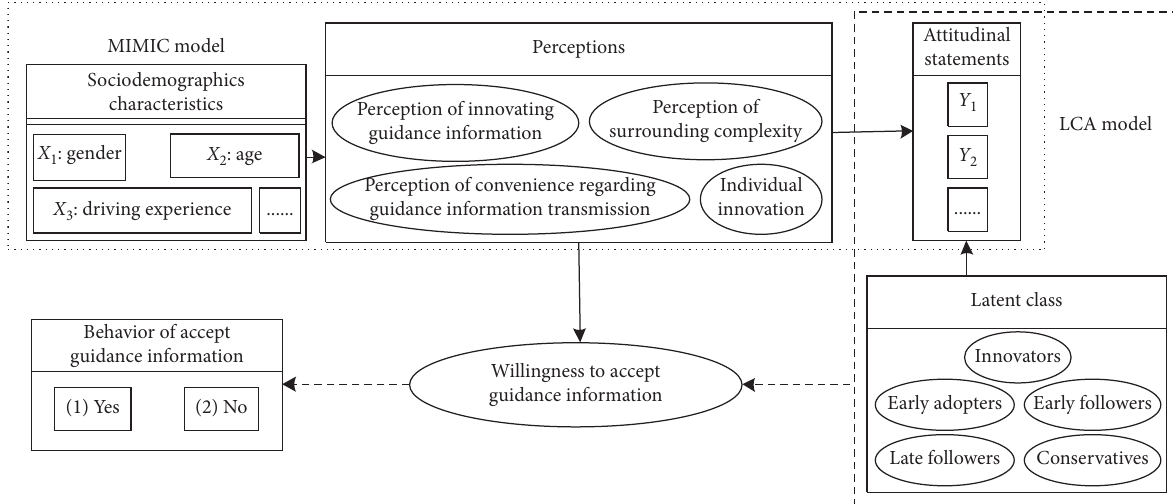
Figure 2: The model framework of drivers’ compliance behavior to guidance information at signalized